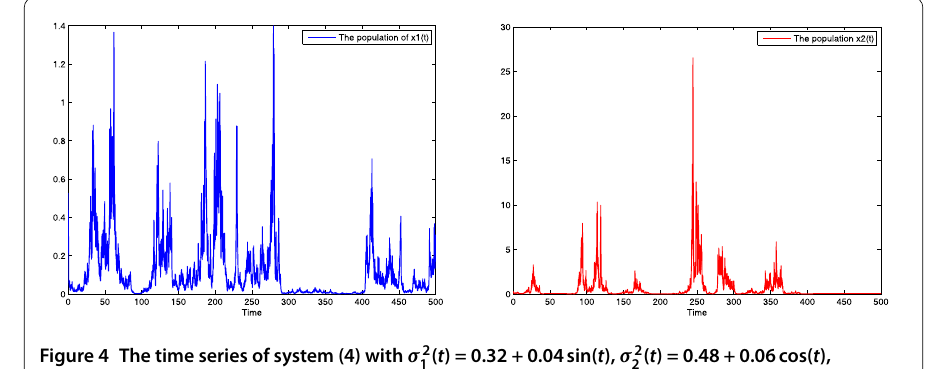
Figure 4 The time series of system (4) with σ 2